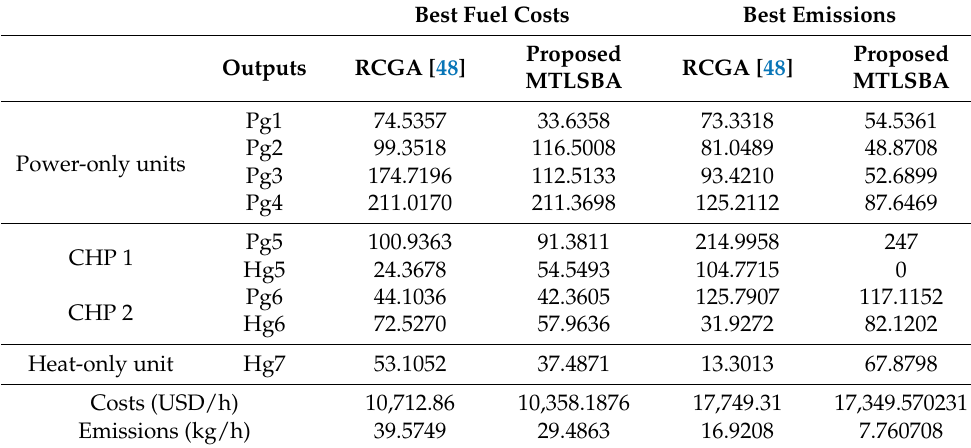
Table 4. Results of best fuel costs and emissions of test system 2 using the proposed MTLSBA. Best Fuel Costs Best Emissions Proposed Outputs RCGA [48]